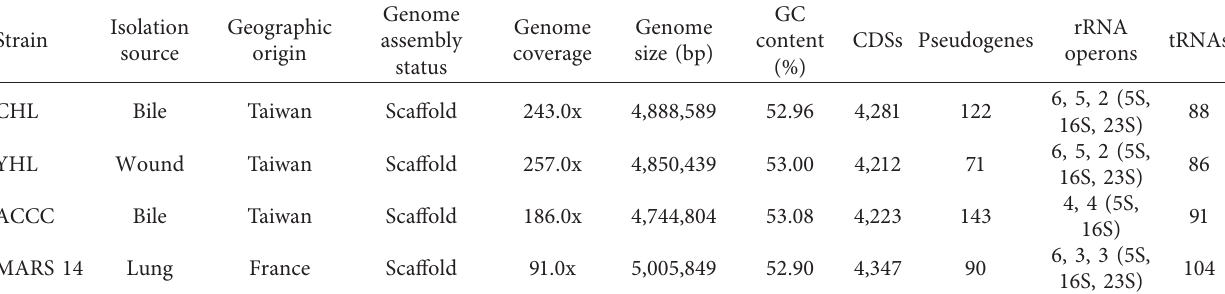
Table 1: Strains and genomic features of S. algae strains in this